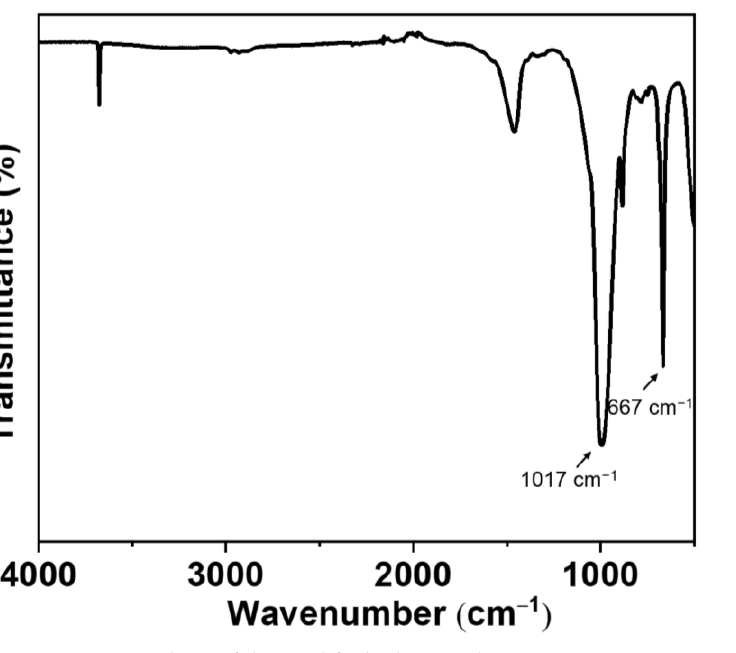
Figure 4. FTIR analysis of the modified talc nanosheet.